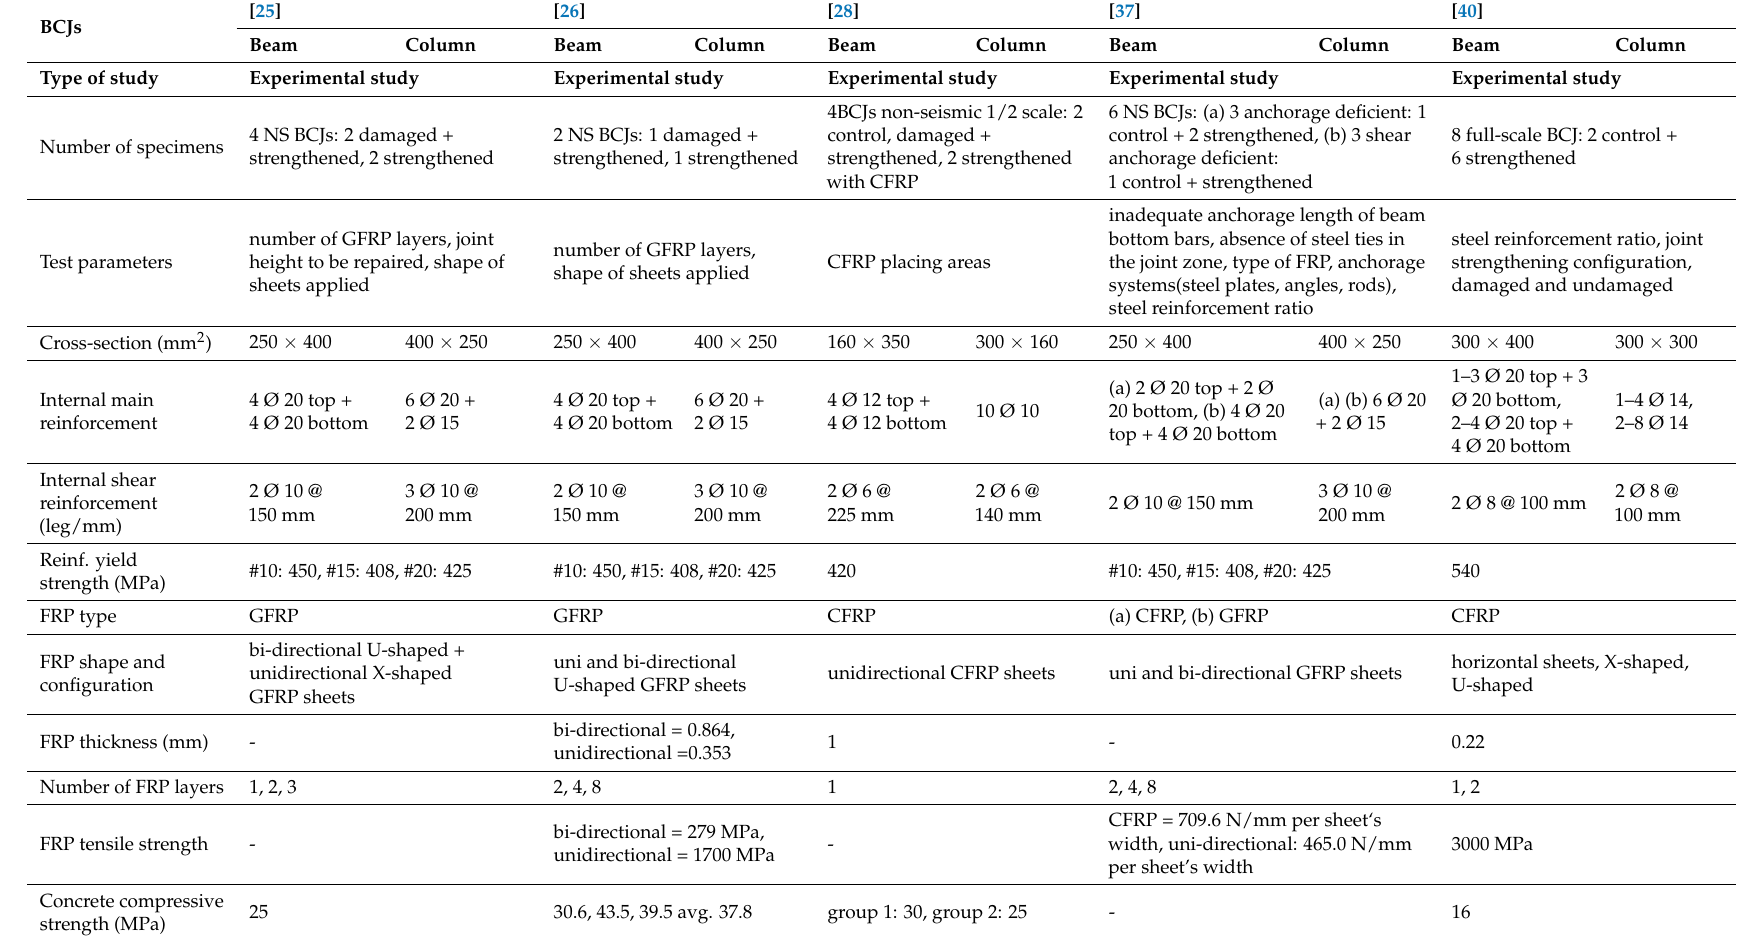
Table 2. Summary of experimental work on BCJs externally reinforced with FRP using steel